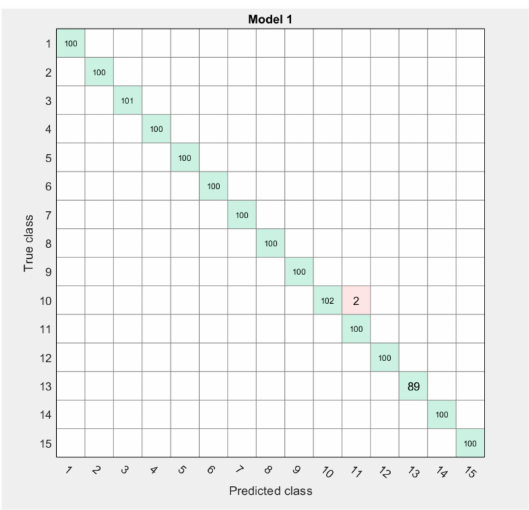
Figure 18. Confusion Matrix of